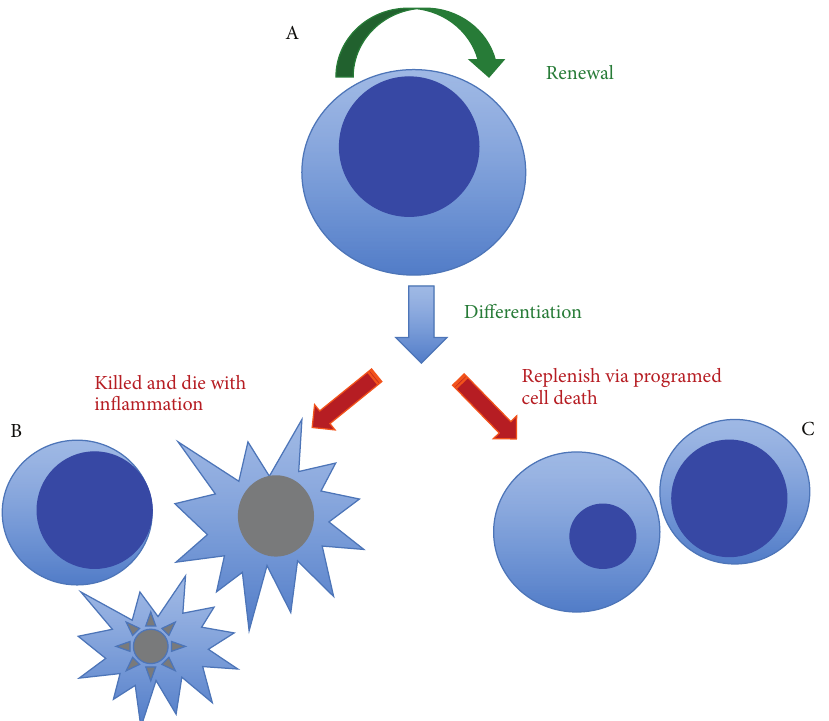
Figure 1: A trinity of cure by CD4 T-cell turnover. P21, cytokine, and immunotherapy can affect all three processes indicated by A, B, and C. Through cell renewal and turnover, one can regulate CD4 T-cell pool size, reprogram T-cell immune memory repertoire, and modulate immune activation and function thereby to reconstitute patient immunity towards an HIV